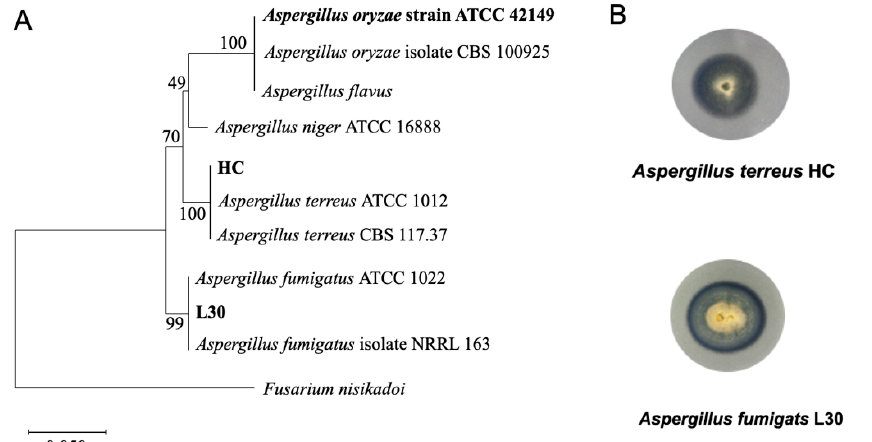
Figure 1. Phylogenetic tree of ITS and clear zone formation on PBSA agar plates. ( A ) A phylogenetic tree of two selected fungal strains ( Aspergillus terreus HC and Aspergillus fumigatus L30) was constructed from a comparison of sequences of approximately 400 bp of the internal transcribed spacer (ITS) region using neighbor-joining analysis of a distance matrix with Kimura’s two-parameter model. Bootstrap values (expressed as percentages of 1000 replications) greater than 75% are shown at branch points. A reference fungal strain, Aspergillus oryzae RIB40 (ATCC42149), was used as a control in this study, and Fusarium nisikadoi was used as an outgroup. The scale bar represents 0.05 substitutions per nucleotide position. ( B ) Morphology of the elite PBSA-degrading fungal strain.